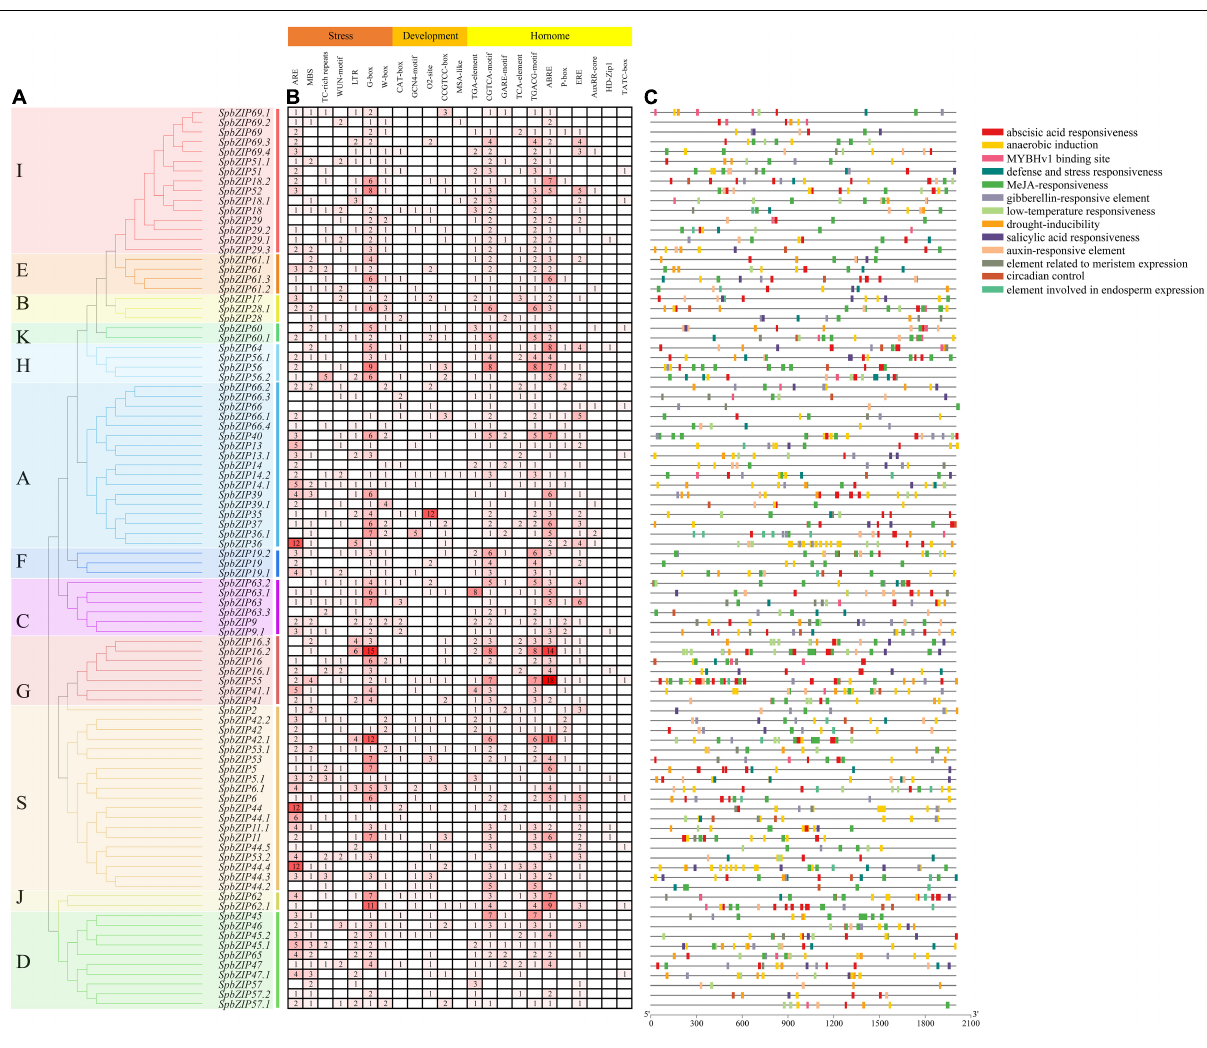
Frontiers in Plant Science |